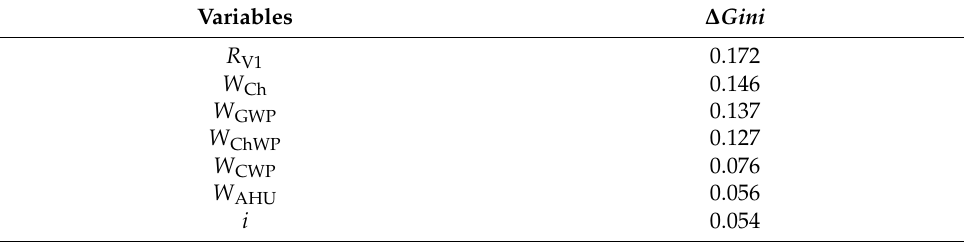
Table A4. ∆ Gini values for variables at node 2.